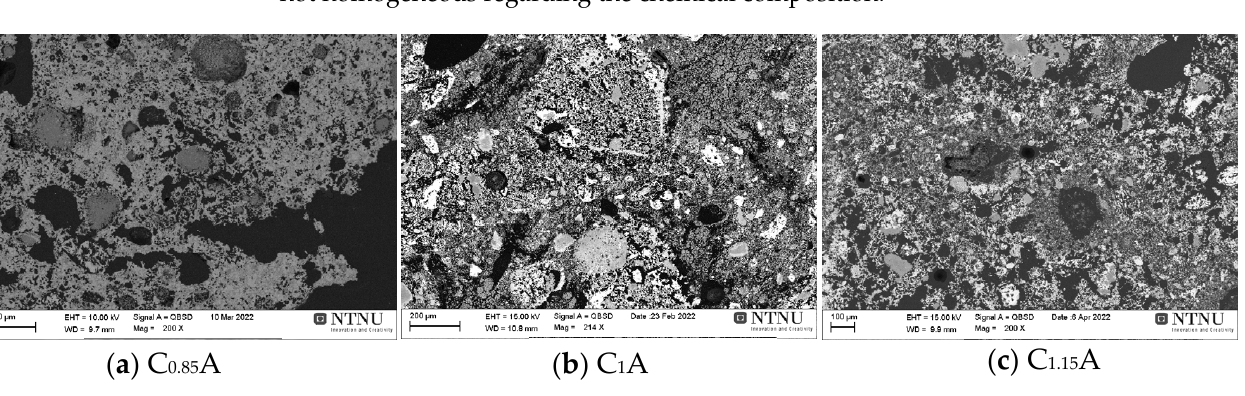
Figure 9. SEM backscattered electron images of three different pellet compositions sintered at 1150 °C ( a ) C 0.85 A, ( b ) C 1 A, ( c ) C 1.15 A.